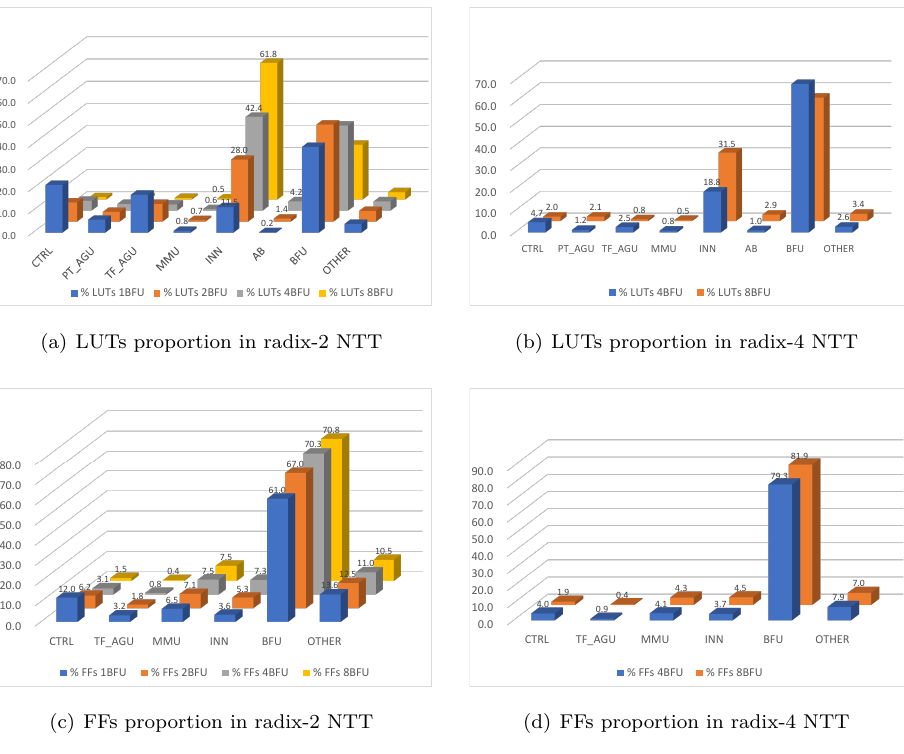
Figure 11: The variation of LUTs/FFs proportion in radix-2 and radix-4 NTT. Figure 11 indicates the variation of LUTs and FFs proportion in radix-2 and radix-4 NTT (N = 1024, 14-bit q) with different number of parallel butterfly units (parallel degrees) on the FPGA platform. The CTRL represents the control unit and the PT_AGU, TF_AGU are address generator units tailored for data points and twiddle factors, respectively.